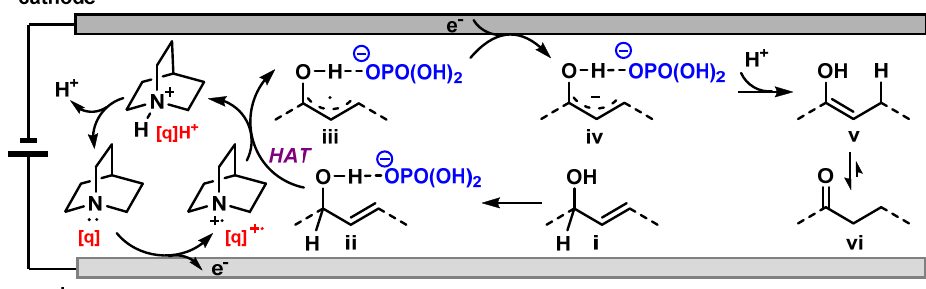
Figure 5. Proposed mechanism for the electrocatalytic isomerization of allylic alcohols.